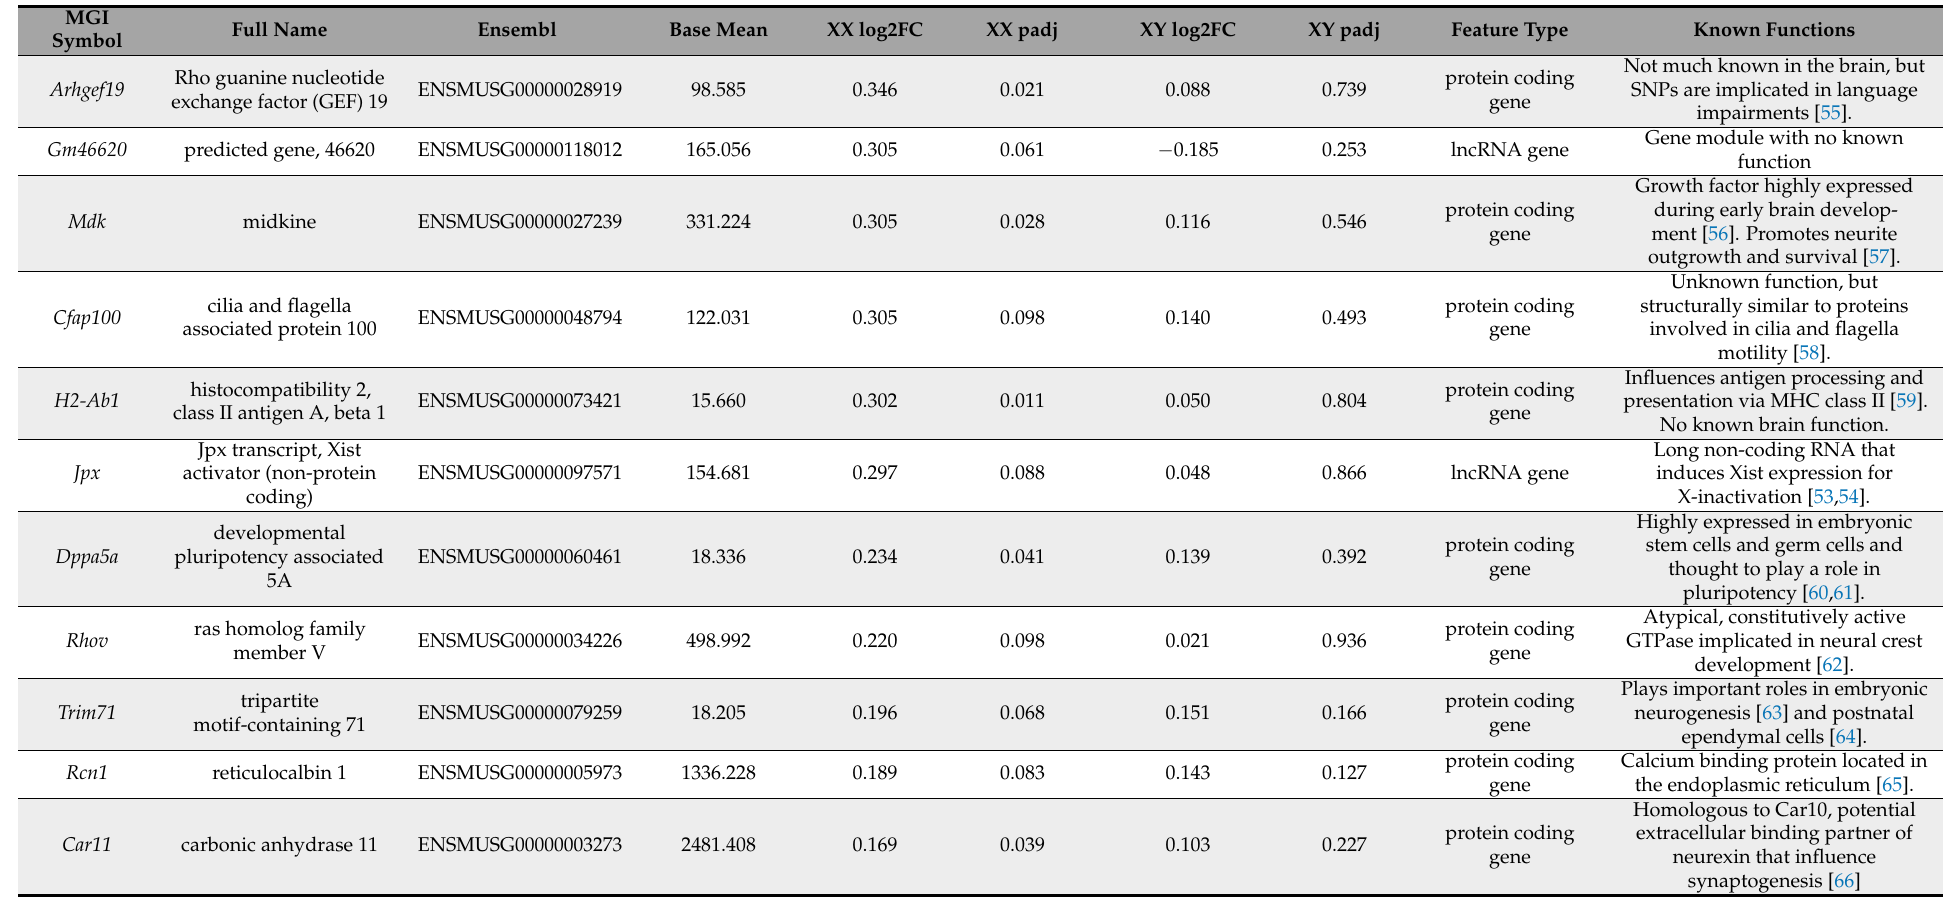
Table 1. Eleven genes significantly upregulated in the Kdm5c-HET female but not in the Kdm5c -KO male